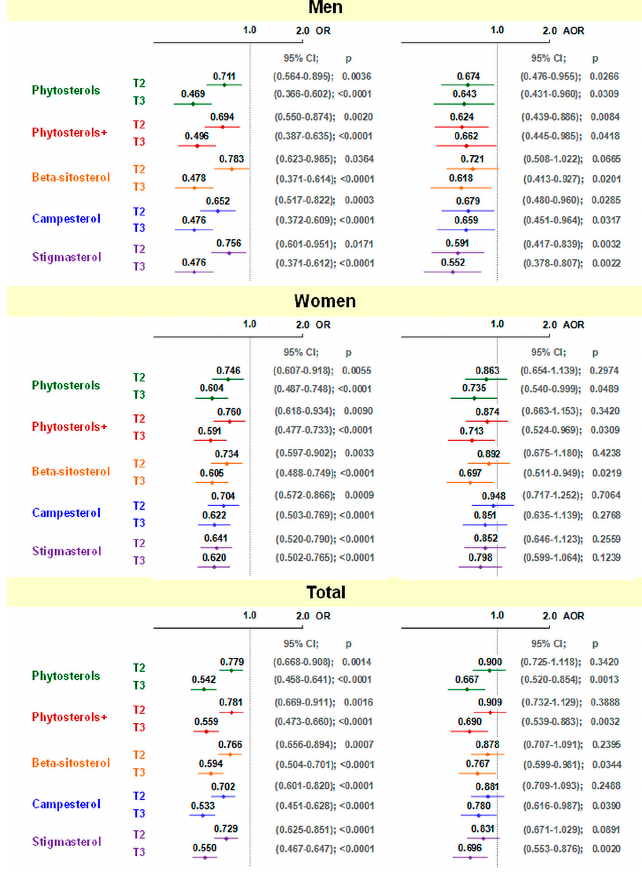
Figure 1. Odds ratio (95% confidence interval) for CVD in relation to total and individual phytosterol intake (relative to 1st tercile). T2—2nd tercile; T3—3rd tercile; OR—odds ratio; AOR—adjusted odds ratio; ORs were unadjusted in men and women but adjusted for sex combined; AORs—adjusted for age, lipid-lowering medication, HDI, BMI, alcohol, and additionally for sex in total.